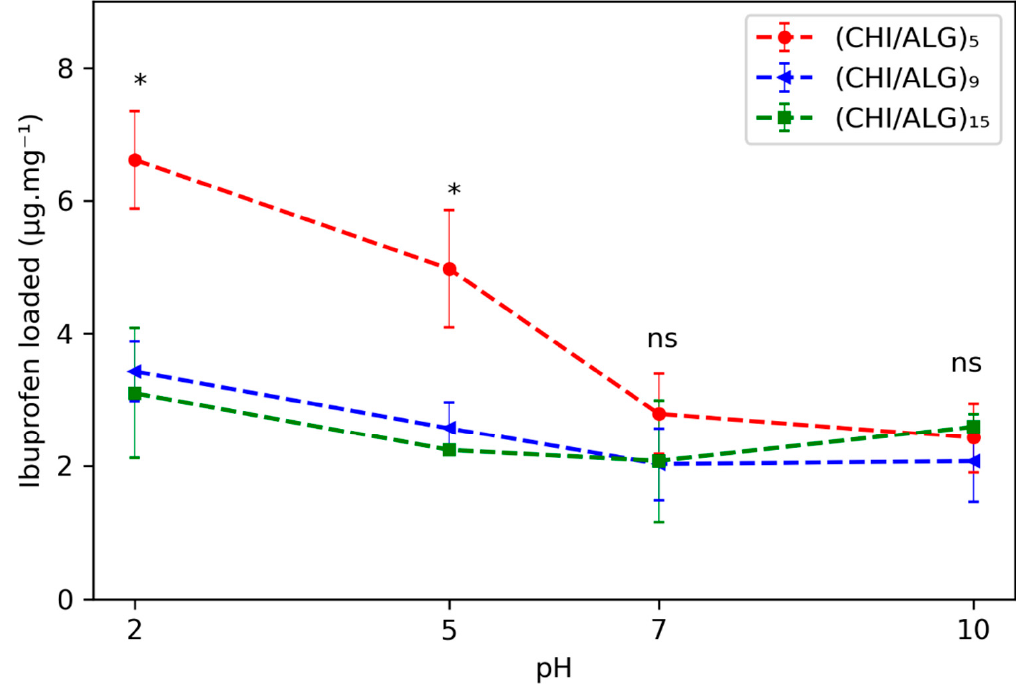
Figure 6. Amount of drug loaded onto the meshes pHs after 15 m of immersion in a saturated solution of IBU at pH 2.0, 5.0, 7.0, and 10.0. Statistical significance between (CHI/ALG) 5 and (CHI/ALG) 9 or (CHI/ALG) 15 is highlighted with a * and non-significant differences between amounts are indicated with text (ns).